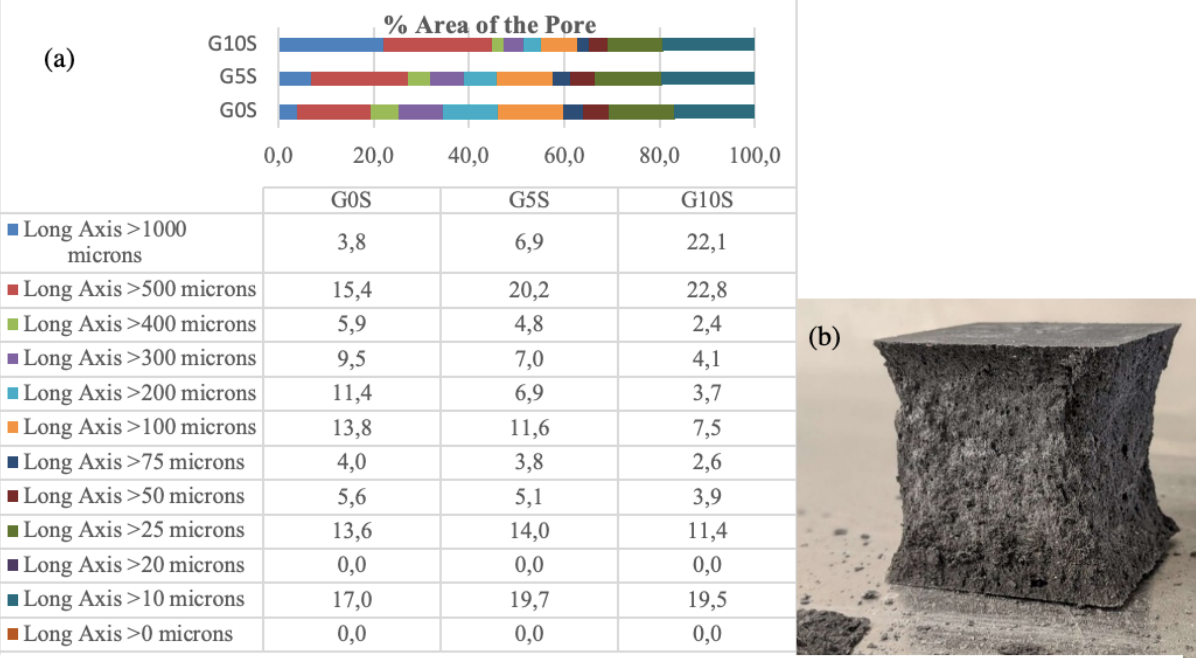
Figure 6. (a) Porosity Distribution in HPFRGC measured with QEMSCAN analysis ; (b) Fractured HPGC specimen with bright core at 28 days.